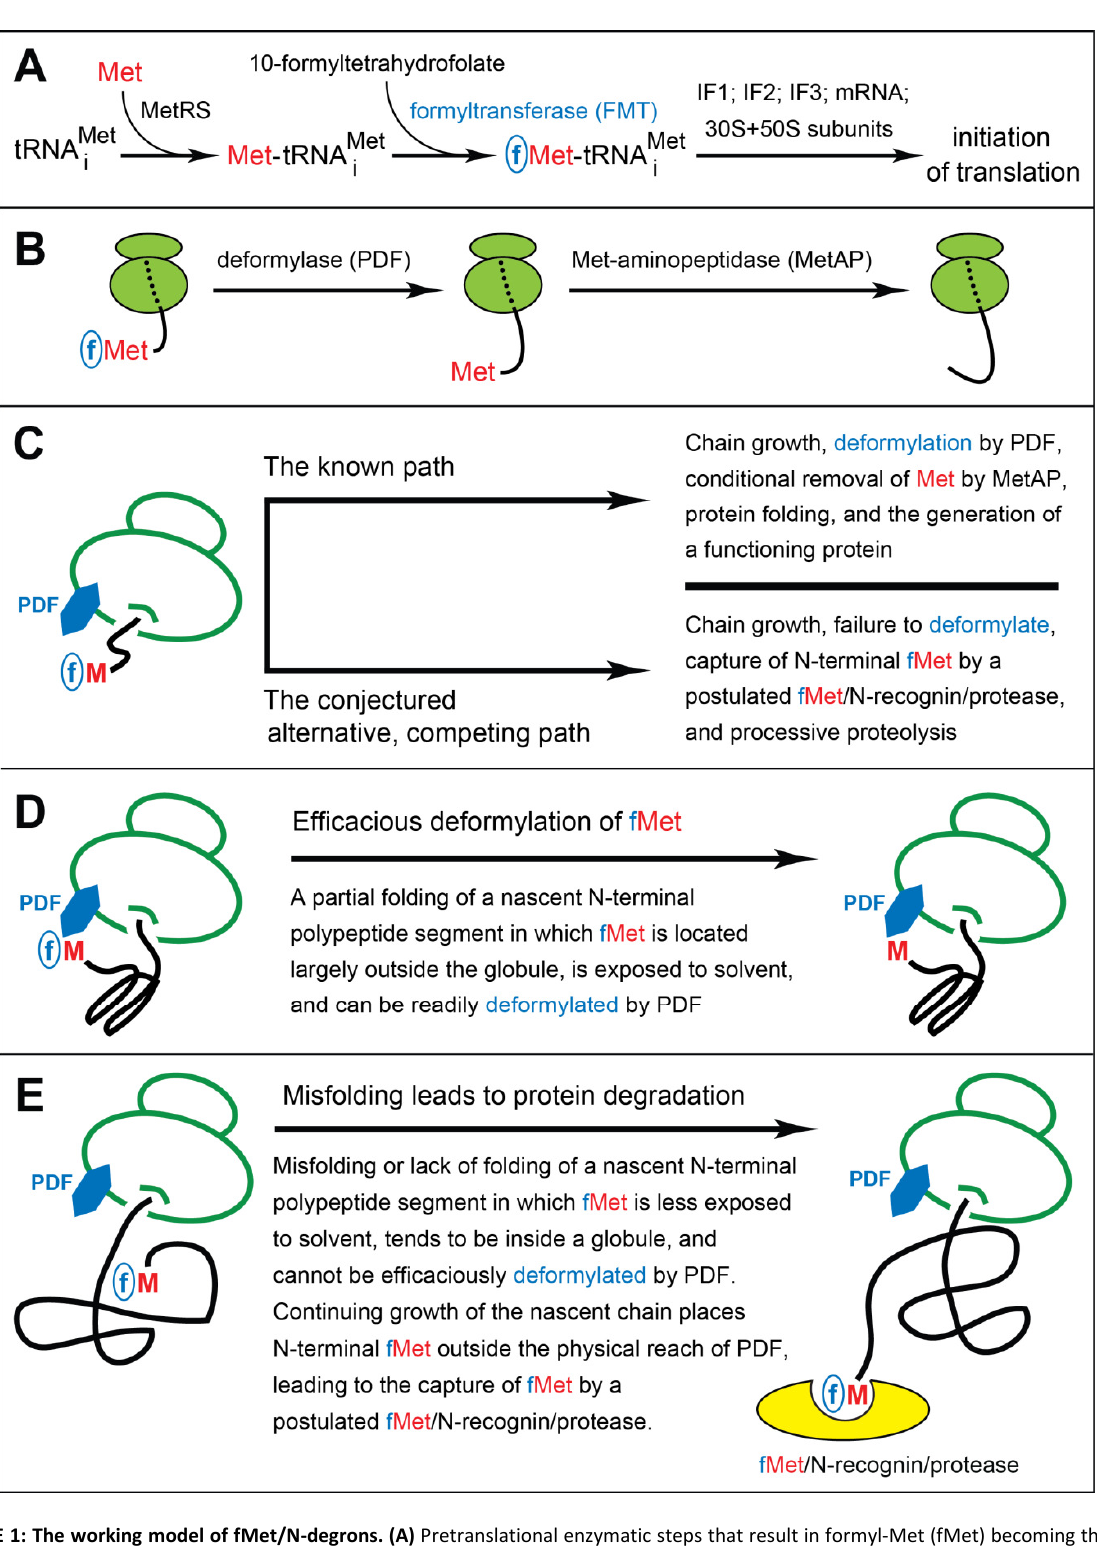
OPEN ACCESS | www.microbialcell.com